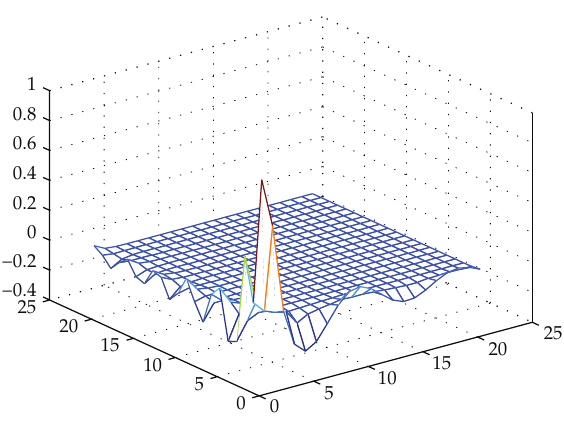
Figure 1: State variable x 1 of system (cid:2) 2.1 (cid:3) .